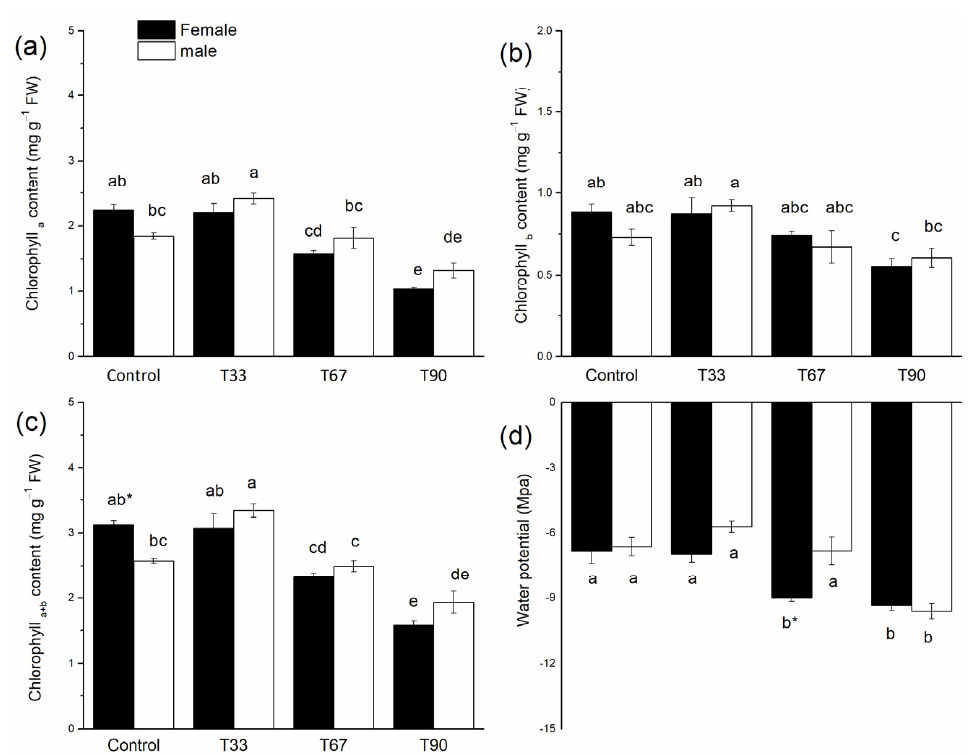
Figure 3. Mean values ( ± SE, n = 5) of chlorophyll content and water potential of female and male saplings of H. rhamnoides under different sand burial treatments: ( a ) chlorophyll a content; ( b ) chlorophyll b content; ( c ) total chlorophyll a+b content; ( d ) water potential. Different lowercase letters indicate significant differences between sand burial treatments according to Bonferroni’s test ( p < 0.05). * indicates significant differences between female and male individuals at the same burial depth ( p < 0.05).